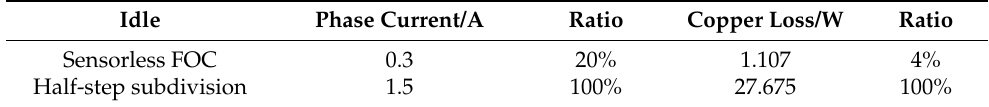
Table 3. Copper loss in idle operation.